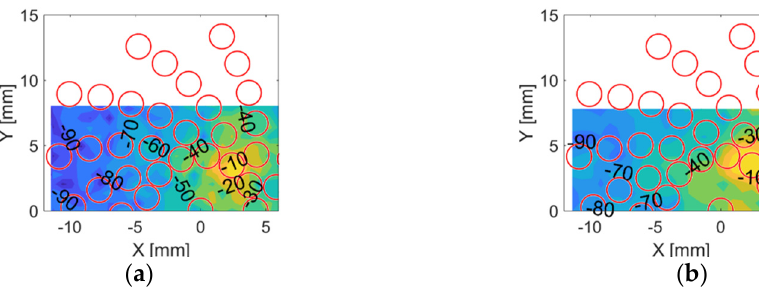
Figure 8. Cross-talk contours for ( a ) the CECAT and ( b ) the C1–3 when firing the first element in the 3rd arm individually. The red circles represent the theoretical position of the neighbouring elements.